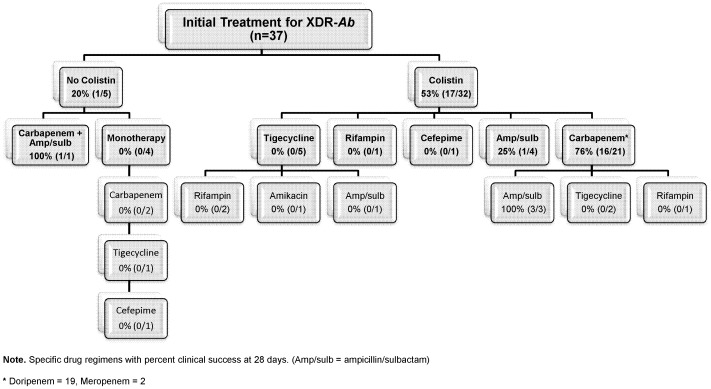
This figure provides a breakdown of each specific treatment regimen used among 37 solid-organ transplant recipients with XDR-Ab infections.The rates of 28-day clinical success for each regimen are listed.